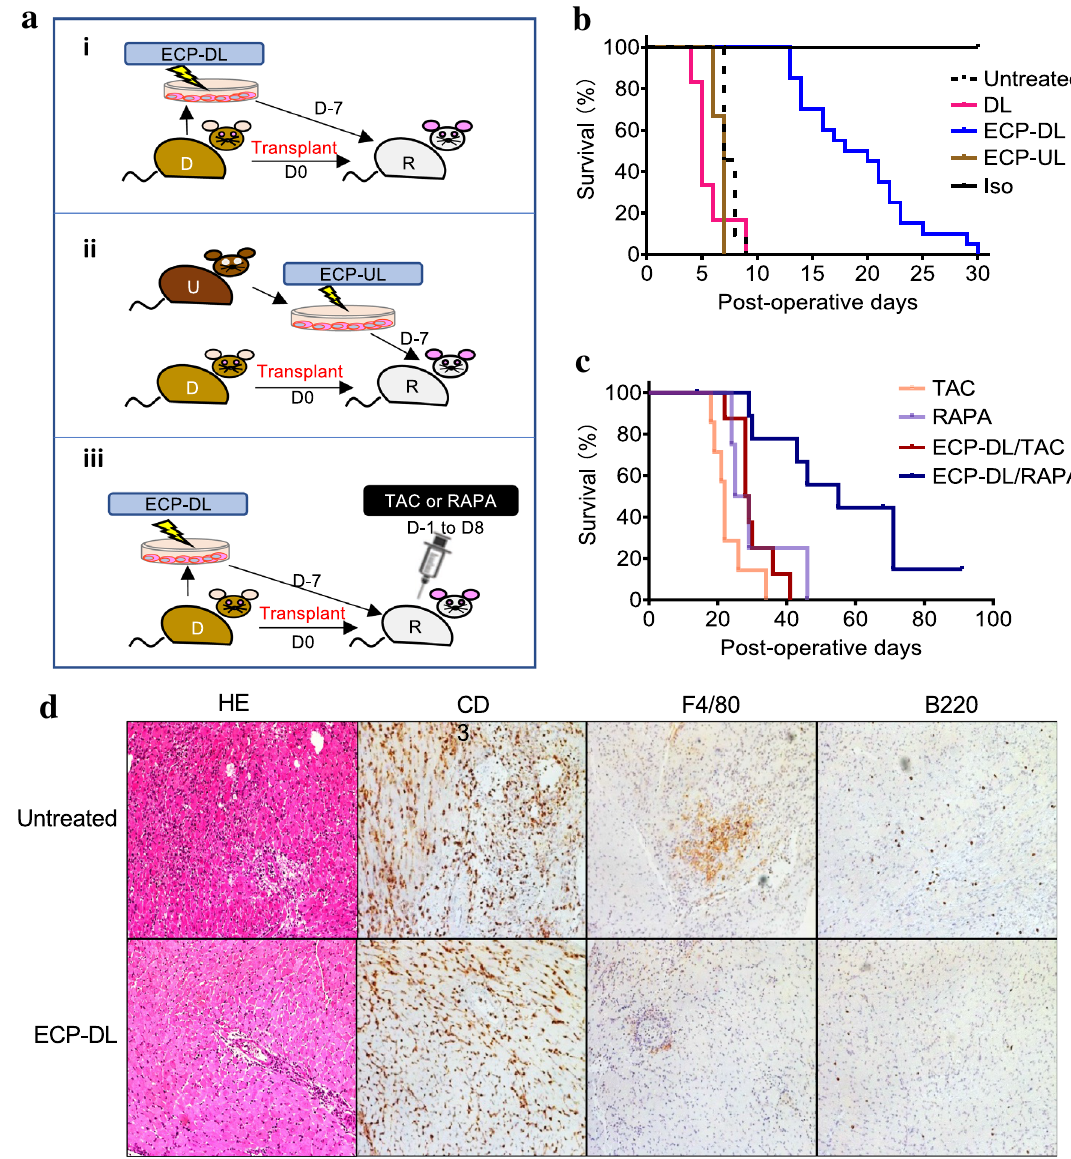
Figure 1. ECP-DL infusion prior to transplantation significantly prolonged cardiac allograft survival in MHC- mismatched mouse models; the addition of TAC or RAPA was synergistic and resulted in further improvement of graft survival. Mouse models of heterotopic cardiac transplantation (BALB/c to B6) were used to test the efficacy of ECP-DL in cardiac allograft rejection. ( a ) Pictorial representation of models utilized. ECP-DL from BALB/c into B6 on D-7 followed by heart transplant on D0 (i); ECP-UL from third party (C3H) into B6 on D-7 and heart from BALB/c on D0 (ii); ECP-DL on D-7 and heart on D0 from BALB/c into B6 plus short-course TAC or RAPA from D-1 to D8 (iii). ( b ) Kaplan Meier Curves demonstrating that ECP-DL infusion (n = 20) resulted in prolonged cardiac allograft survival compared to Untreated (n = 11), DL (n = 6), and ECP-UL (n = 3) groups. The Isograft group survived indefinitely (n = 6). ECP-DL versus Untreated, DL, or ECP-UL, **** p < 0.0001, by Log-rank test. ( c ) Kaplan Meier Curves showing ECP-DL was synergistic with TAC or RAPA. TAC (n = 8); RAPA (n = 4); ECP-DL/TAC (n = 8); ECP-DL/RAPA (n = 10). ECP-DL/RAPA versus RAPA, * p < 0.05; ECP-DL/TAC versus TAC, * p < 0.05; by Log-rank test. ( d ) Representative hematoxylin and eosin, CD3, F4/80, and B220 staining of cardiac allografts from untreated versus mice receiving ECP-DL. Grafts from ECP-DL treated animals had reduced inflammatory cellular infiltrates. The composition of the infiltrates was further characterized by the staining of CD3 (T-cells), F4/80 (monocyte/macrophages), and B220